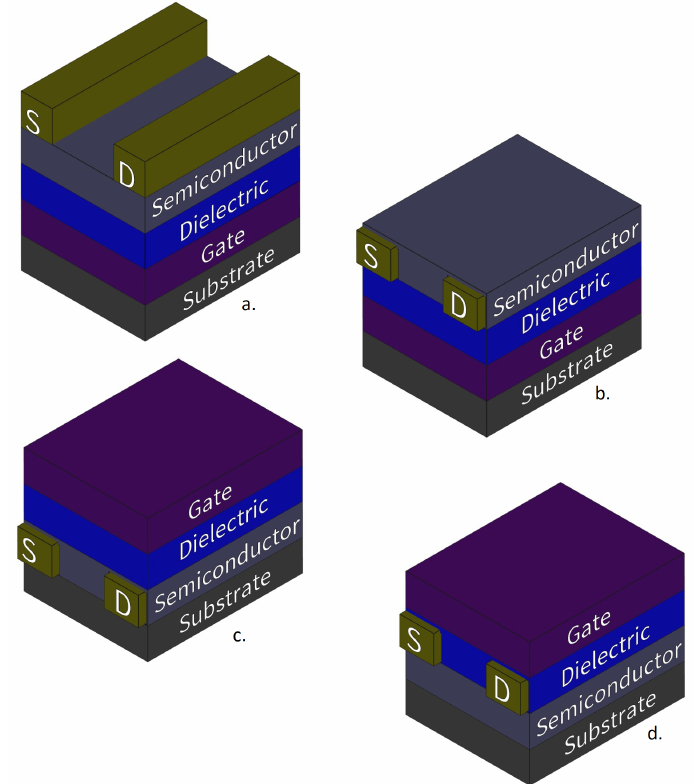
Figure 2. Different architectures of OFETs. ( a ) top-contact bottom-gate, ( b ) bottom-contact bottom- gate, ( c ) bottom-contact top-gate and ( d ) top-contact